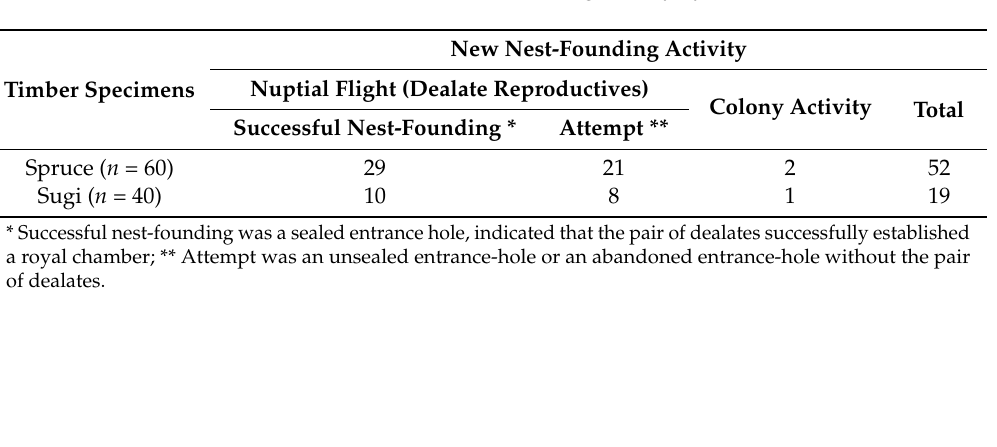
Table 1. The record of new nest-founding activity by I. minor